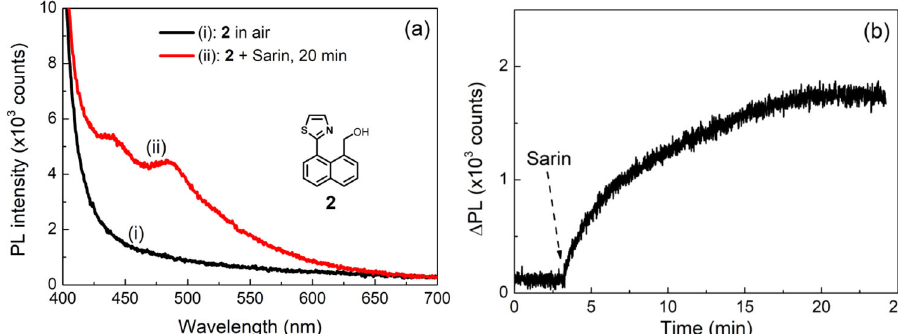
Fig. 3 PL response of sensing compound 2 to Sarin. PL spectra ( a ) and time-dependence ( b ) of solid-state fi lms with 2 in cellulose acetate before and after the introduction and continuous exposure to the vapor of a stored Sarin sample. A 365 nm LED was used to excite the fi lm. The PL spectra were recorded on an OceanOptics Flame spectrometer and were not corrected. The PL signal in the absence of Sarin in a is due to the tail of the excitation. For the PL time-dependence, the intensity of the emission peak at 484 nm was recorded and the data has been corrected for the scattered excitation.